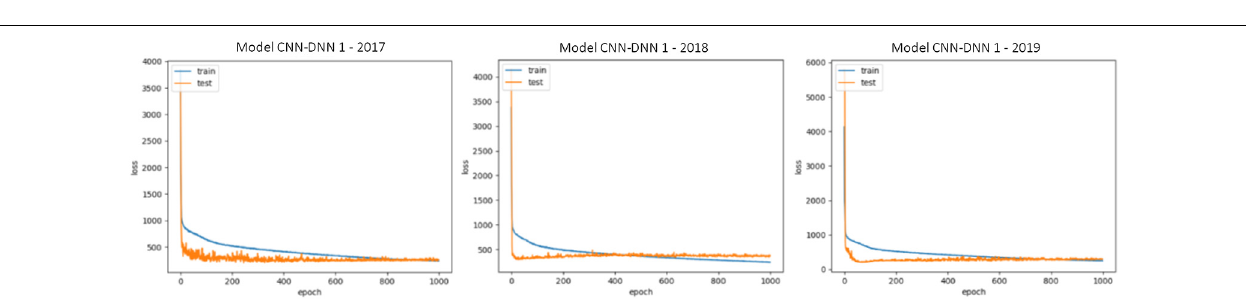
FIGURE 5 | Train and test loss vs. epochs of some of the trained CNN-DNN models. Similar observations were made for all trained models and only some of them are shown for illustration purposes. The shown examples are representative of all the examples.